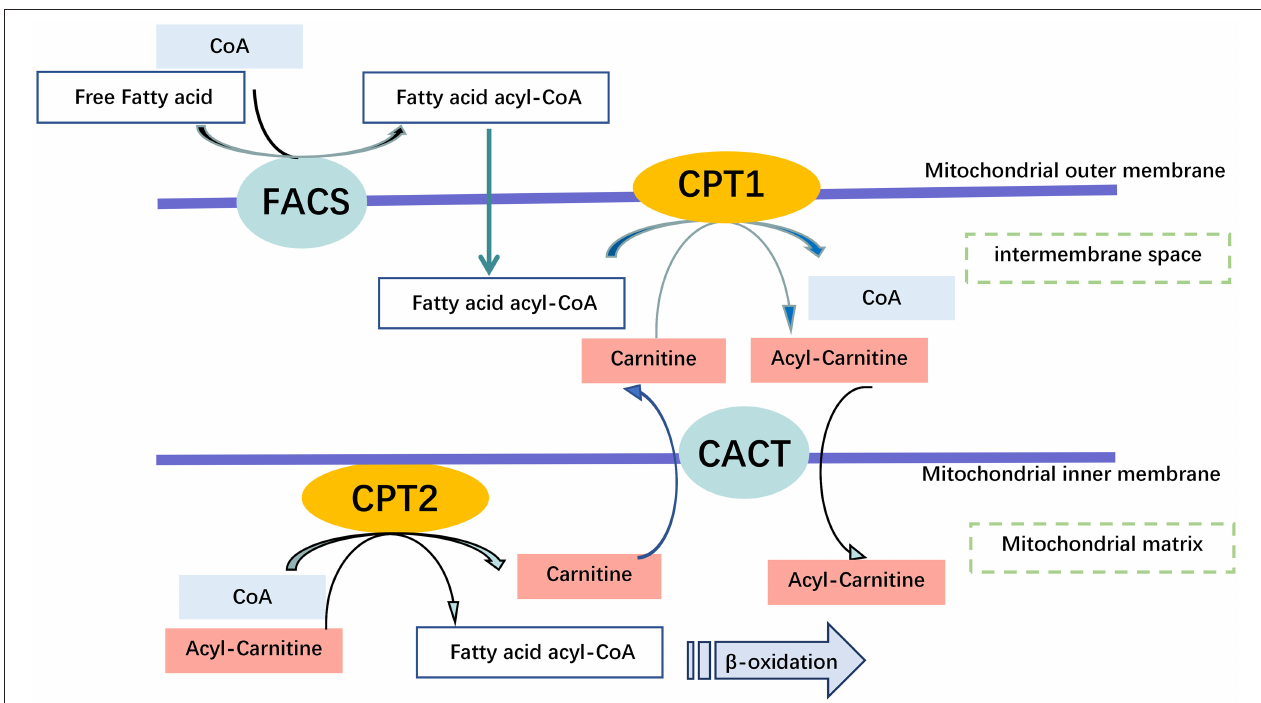
FIGURE 5 | Carnitine Shuttling System. Once the free fatty acid reaches the Mitochondrium, it is processed into a fatty acid acyl CoA molecule by Fatty Acyl-Coenzyme A Synthetase (FACS) to cross the outer mitochondrial membrane. Carnitine is used by Carnitine Palmitoyl transferase 1 (CPT1) to synthesize acyl carnitine, which is shuttled across the inner mitochondrial membrane by Carnitine Translocase (CACT). Finally, acyl carnitine is converted back into carnitine, and a fatty acid acyl-CoA molecule by carnitine palmitoyl transferase 2 (CPT2) for β -oxidation within the mitochondrial matrix, and transport of free carnitine back to the cytoplasm by